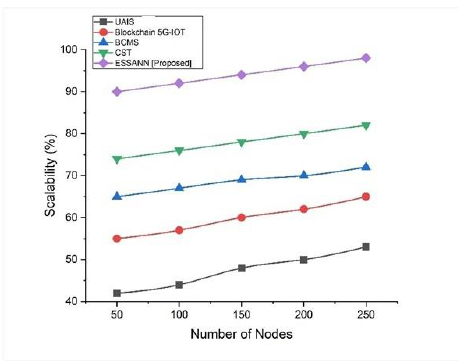
Figure 5. Comparison of scalability [23 – 26].